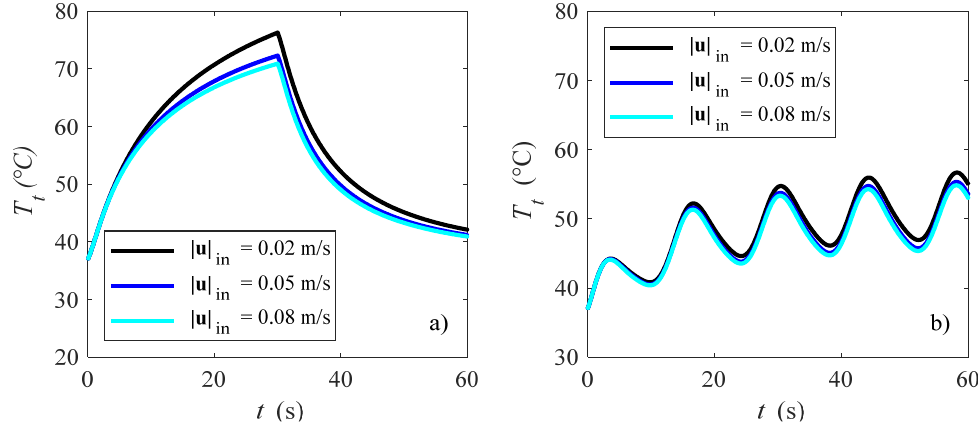
Figure 7. Tissue temperature vs. time for different blood velocities: ( a ) ω * = 1.000 and ( b ) ω * = 0.033 in P (0.0000, − 0.0400, 0.0175).